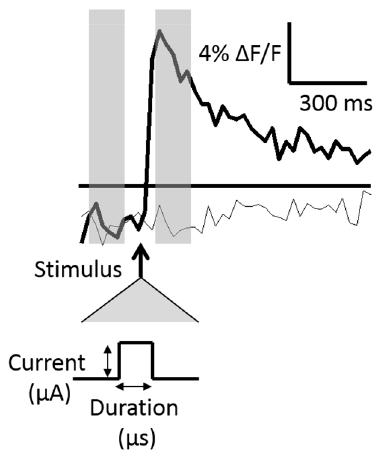
Figure 2. Stimulus-evoked fluorescence traces. Two traces are shown in which an action potential was evoked in response to the stimulus (bold line) and no action potential was evoked (light line). The stimulus timing with respect to the evoked signal is denoted by the bold arrow and is expanded below to show the two stimulus pulse control variables, the current ( μ A) and the pulse width, or duration ( μ s). Action potentials were assumed to occur if the post-stimulus change in fluorescence ( Δ F/F) was greater than three times pre-stimulus levels (threshold shown as a horizontal bar). The pre-and-post-stimulus fluorescence levels were calculated as a time-average of four frames (represented with transparent gray bars).